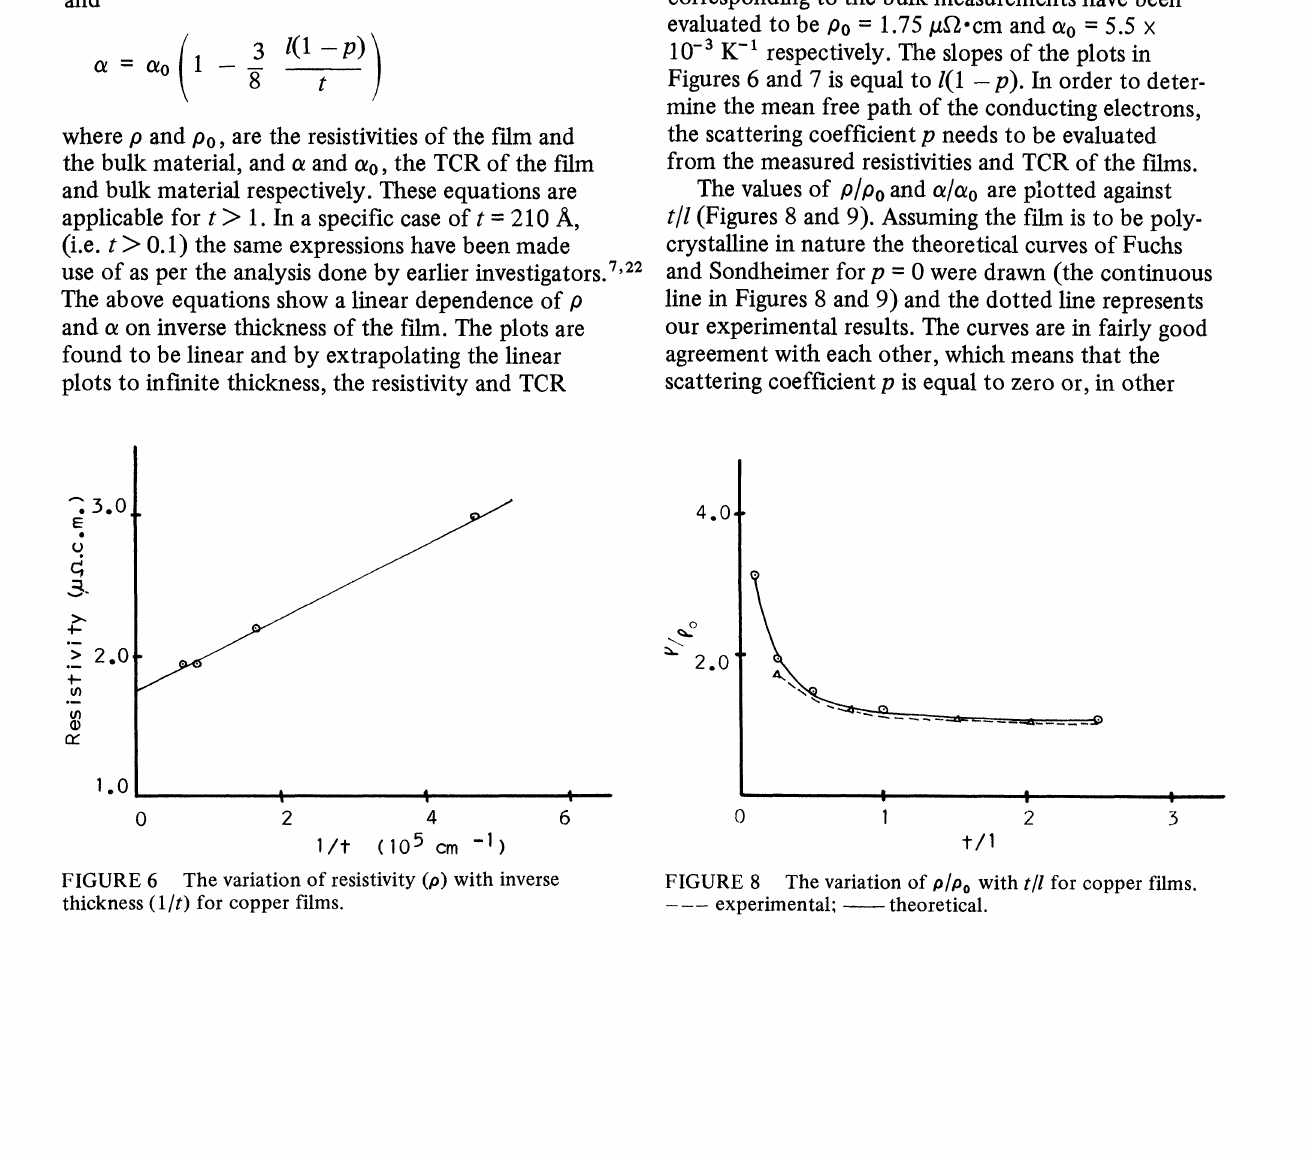
The variation of P/Po with t[1 for copper films. experimental;